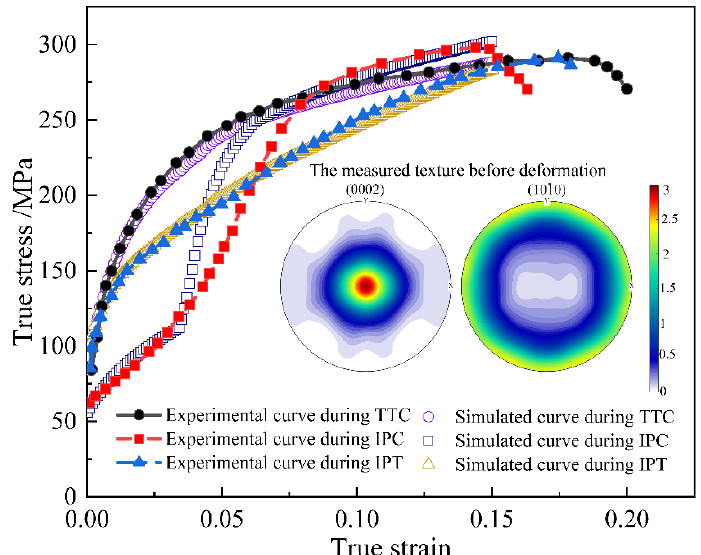
Figure 1. The comparison between the experimental stress–strain curves (lines and symbols) and the corresponding simulated stress–strain curves (symbols) of the AZ31 magnesium alloy under the uniaxial compression along the normal direction (ND), the uniaxial compression along the rolling direction (RD), and the uniaxial tension along the transverse direction (TD) at the true strain of 0.15. (The initial texture and experimental mechanical responses are from Chapuis et al. [24]). TTC, through-thickness compression; IPT, in-plane tension; and IPC, in-plane compression.